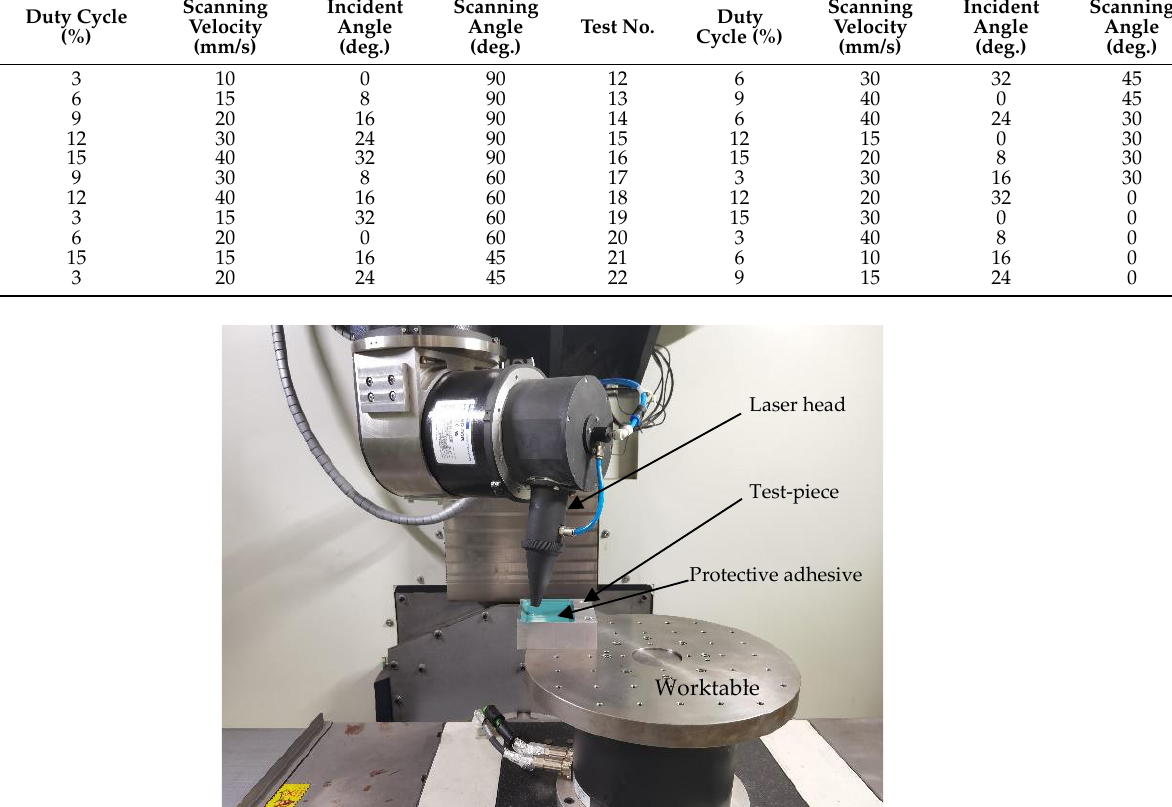
Table 4. Orthogonal test parameters for laser engraving (the laser pulse frequency is 2000 Hz).